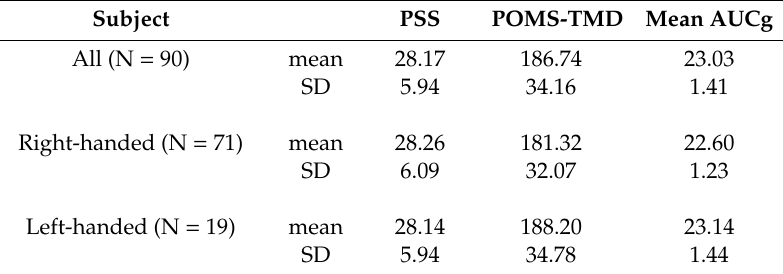
Table 1. Salivary cortisol and mood.